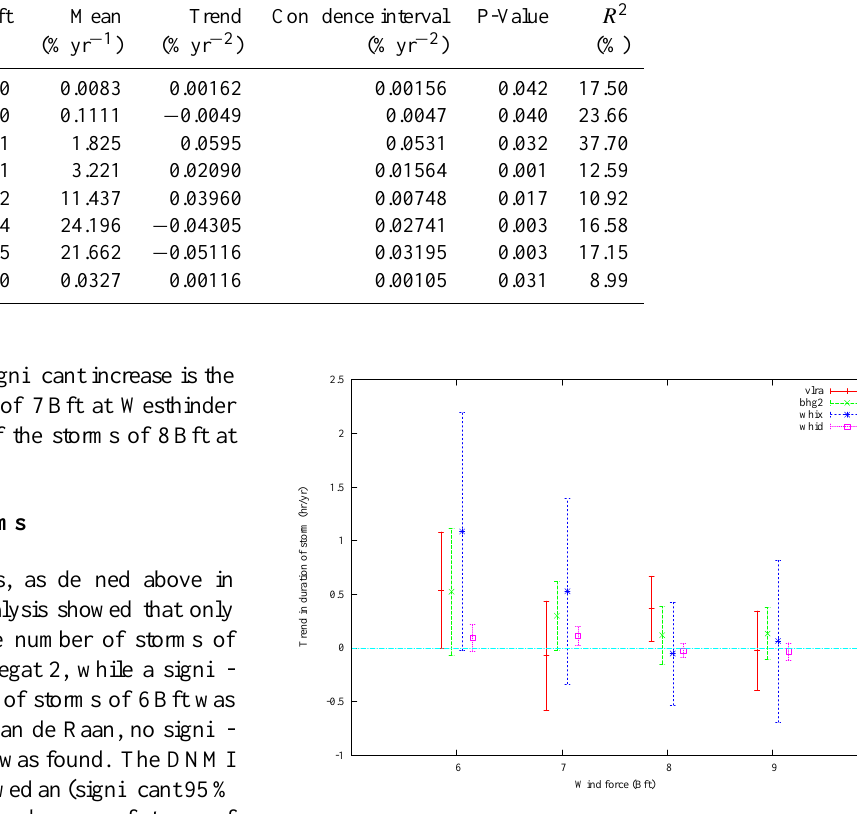
Figure 4: Trend in the duration of the storms for the difference wind forces. vlra: Vlakte van de Raan; bhg2: 2 Fig. 4. Trend in the duration of the storms for the difference in Brouwershavensegat 2; whix: Westhinder; whid: Westhinder DNMI data. The error bars give the 95% 3 wind forces. vlra: Vlakte van de Raan; bhg2: Brouwershavensegat confidence interval. 4 2; whix: Westhinder; whid: Westhinder DNMI data. The error bars give the 95% confidence